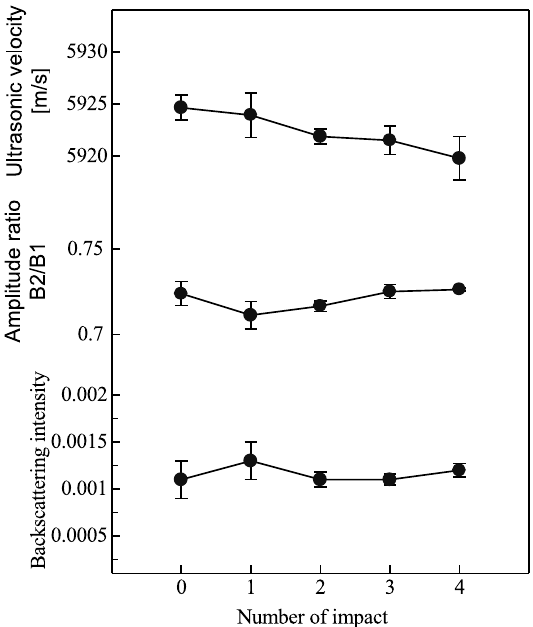
Figure 6. Changes of ultrasonic velocity, amplitude ratio and backscattering intensity during the low-velocity repeated impact test. The data correspond to C-scan images dis- played in the Figure